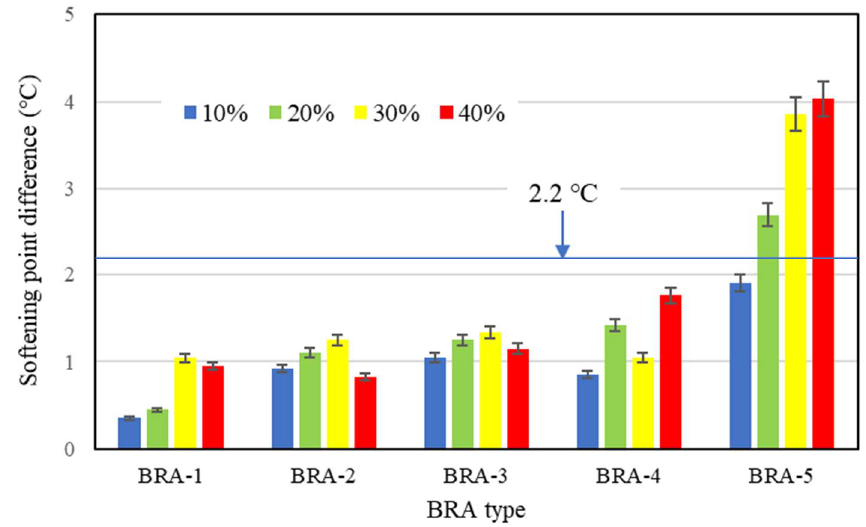
Figure 15. Softening-point difference of BRA-MA.